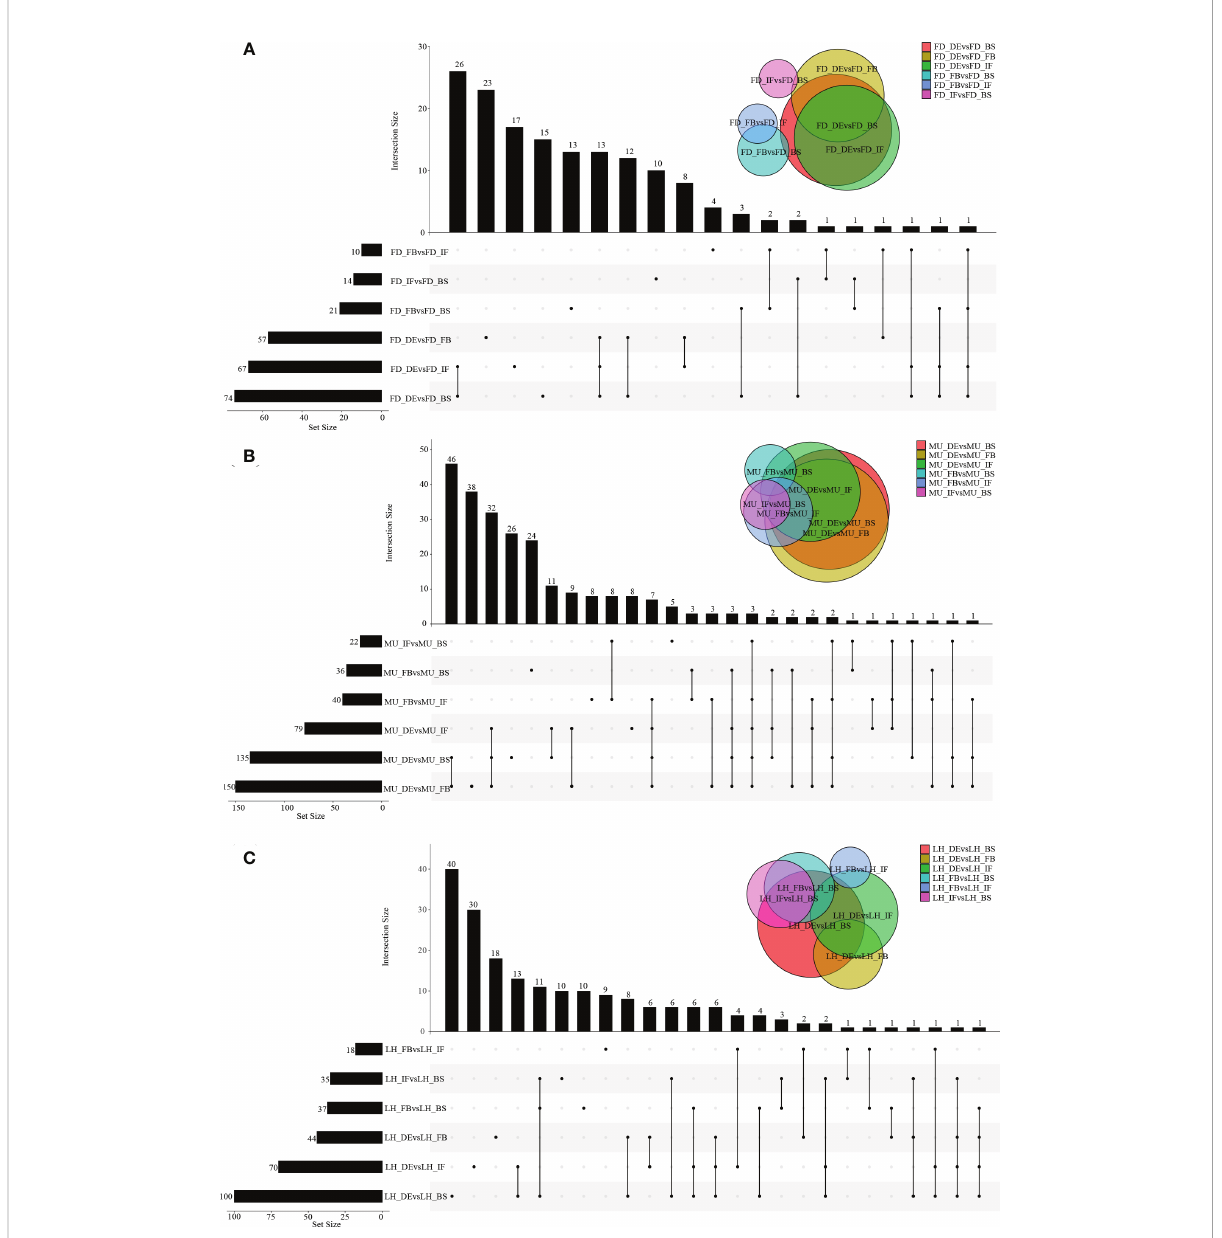
FIGURE 2 The distribution of DEMs across fl ower developmental stages in FD, MU, and LH. (A) The distribution of DEMs across developmental stages (BS, IF, FB, DE) in FD libraries. (B) The distribution of DEMs across developmental stages (BS, IF, FB, DE) in MU libraries. (C) The distribution of DEMs across developmental stages (BS, IF, FB, DE) in LH